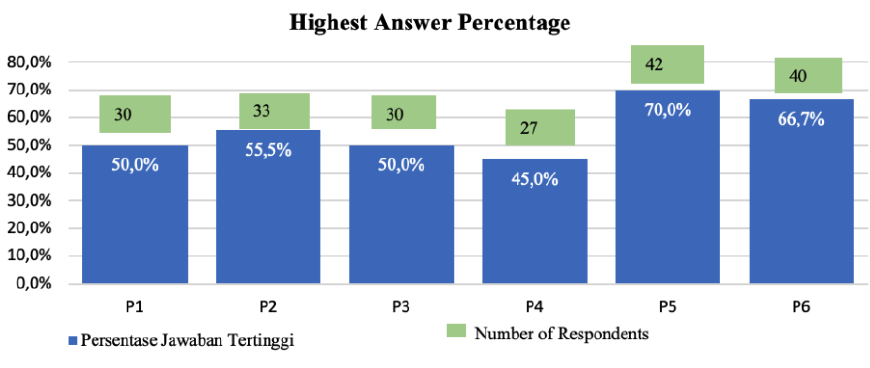
Figure 7: Percentage of Supporters for the Implementation of Career Service Programs by Graduate